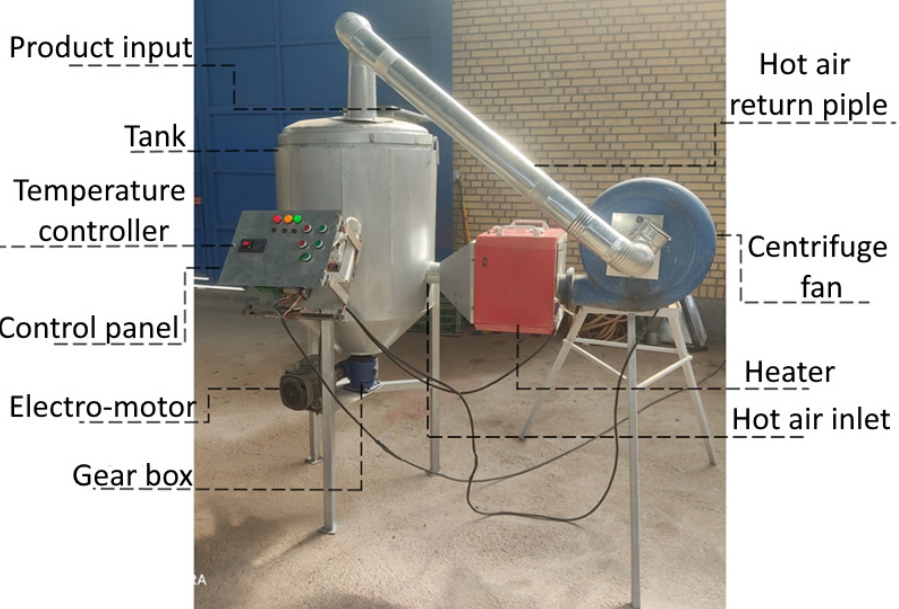
Figure 3. Components of waste dryer. Figure 3 reprinted with permission (copyright © 2022, Elsevier Ltd., Amsterdam, The Netherlands) from Rahmani et al. [69].